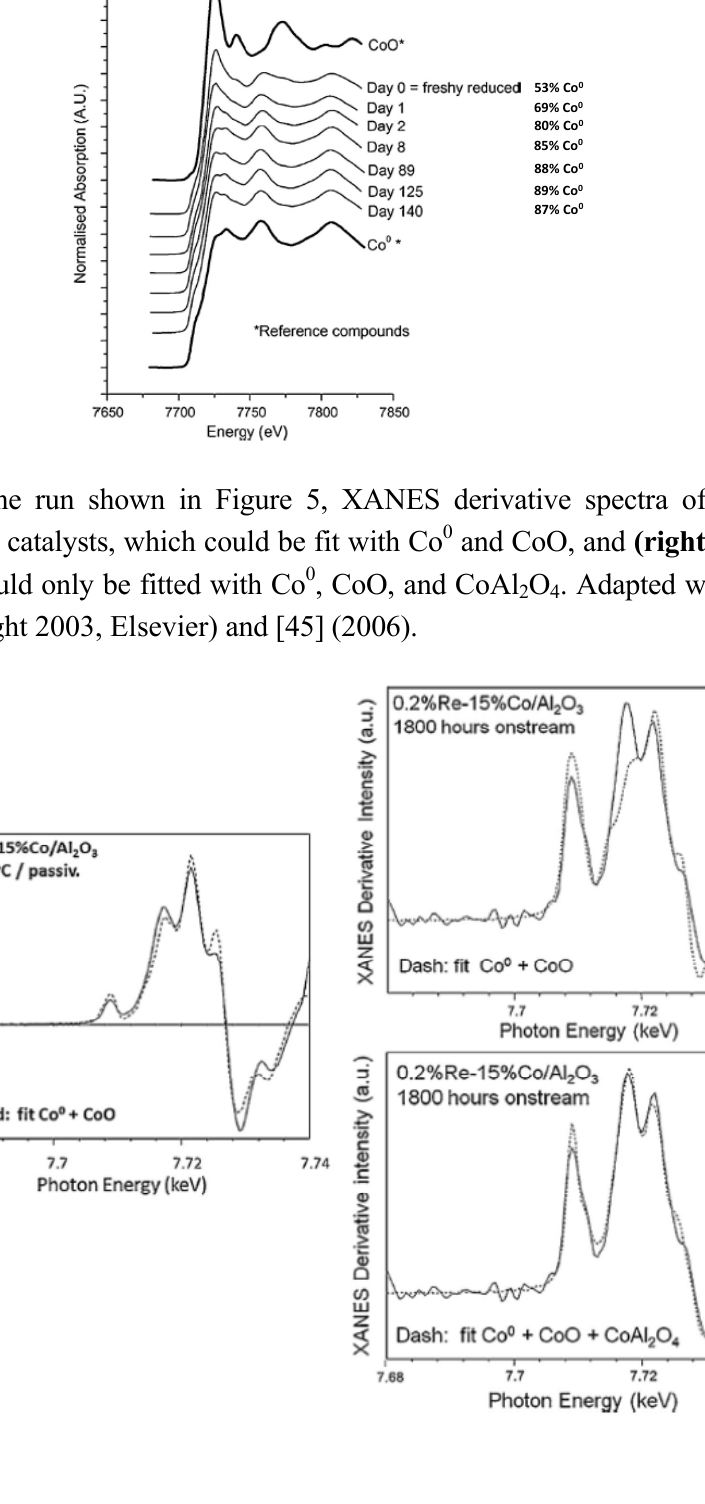
O catalyst samples retrieved from 2 3 + CO) and 2 and 25 vol.% CO, 2